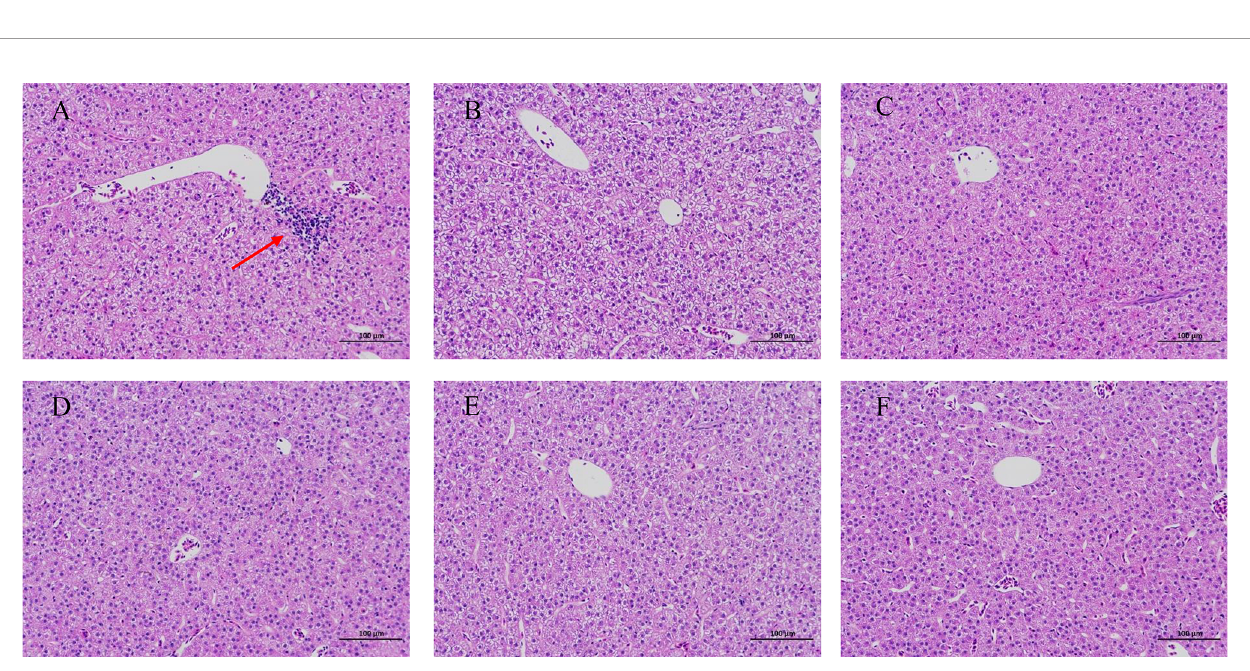
FIGURE 8 | The hepatic HE staining of juvenile blunt snout bream (200X). (A – F) were corresponding to 0%, 0.03%, 0.06%, 0.09%, 0.12% and 0.15% TB supplementation, respectively. The red arrow indicated that a small number of in fl ammatory cells were locally in fi ltrated (A)